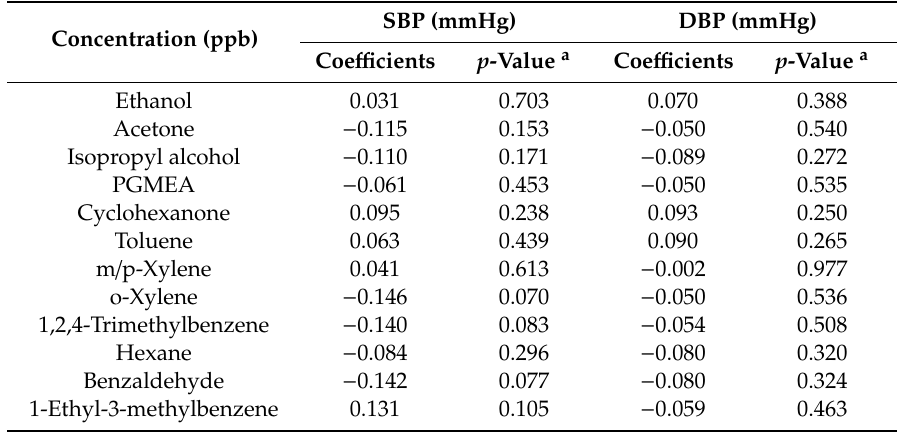
Table 4. Correlation coe ffi cients between specific VOCs levels and blood